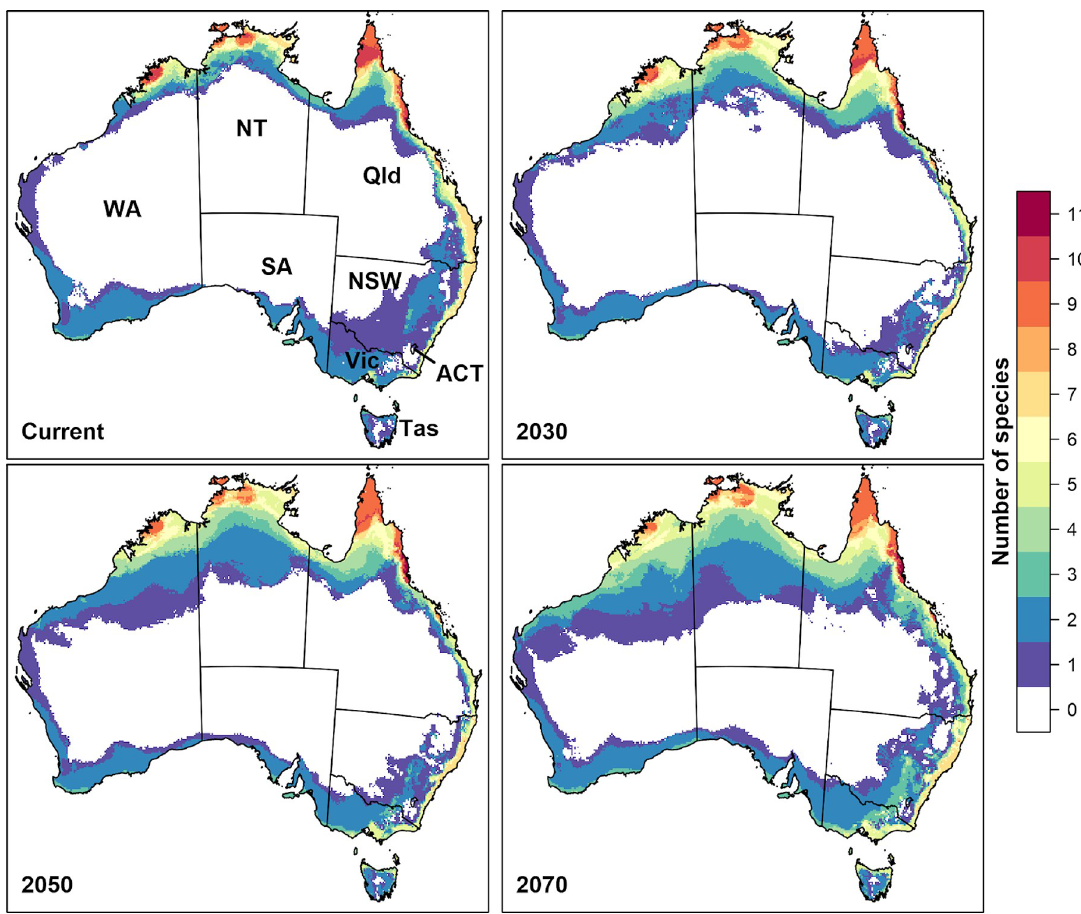
Fig 1. Hotspot maps of habitat suitability for the 11 fruit fly species under climate change, when novel environments are included. Hotspot maps of baseline (1960–1990) and future habitat suitability for 11 fruit flies. Suitability was modelled with Maxent, and thresholded using the 10th percentile of suitability at training presence localities. These maps include projections under novel environments (see S1 File for individual species maps with novel environments included) . Colours indicate the number of species for which habitat is projected to be suitable under the majority ( � 4) future climate scenarios. Figure was created in R version 3.3.3 [57]